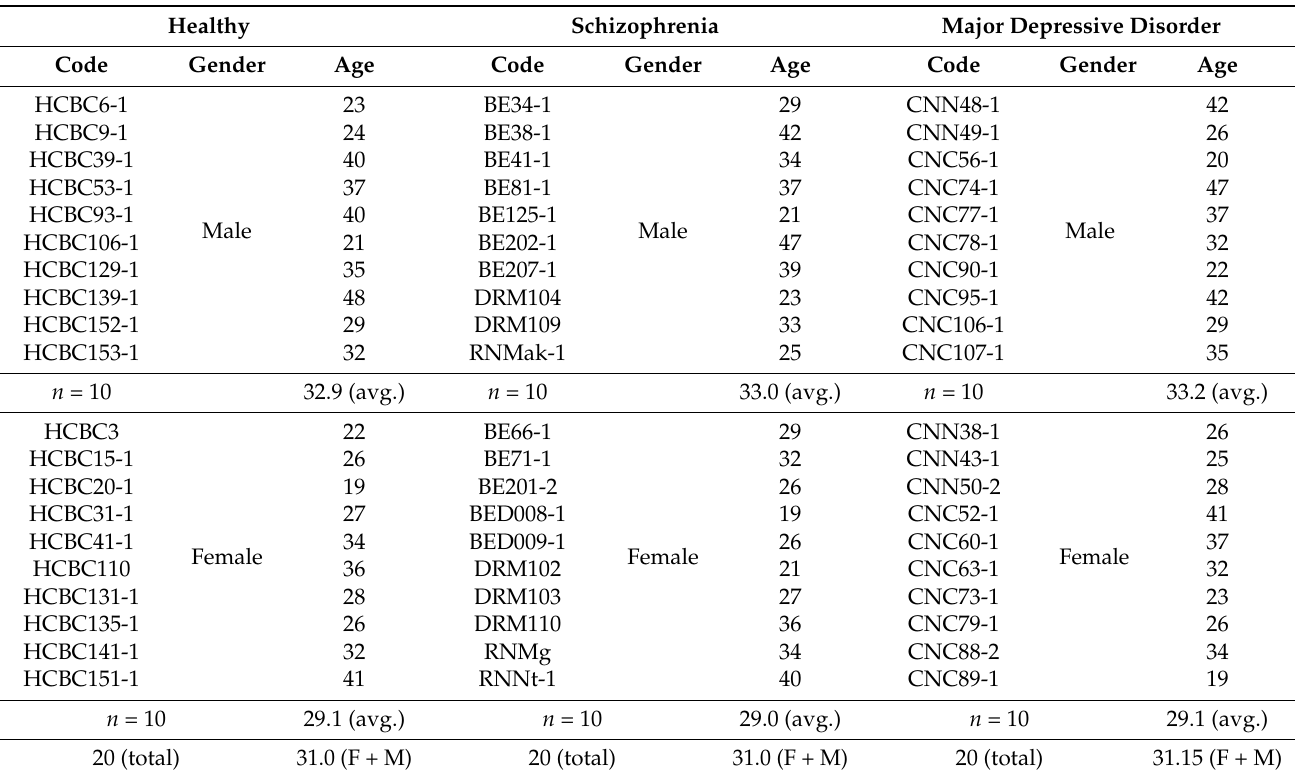
Table 1. Clinical data of the subjects used in this